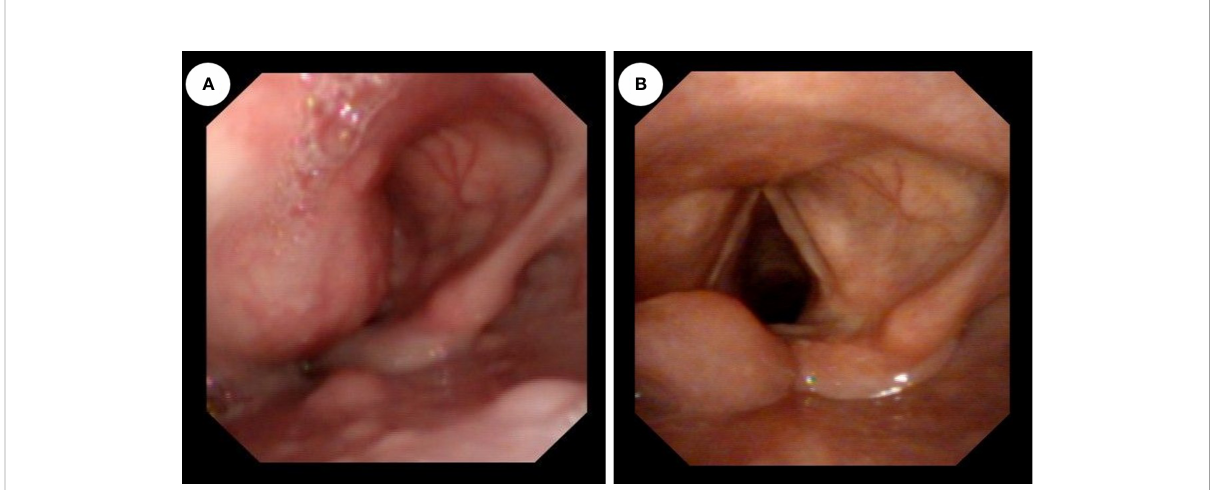
fully exposed, and there were no obvious abnormalities in the hypopharynx.